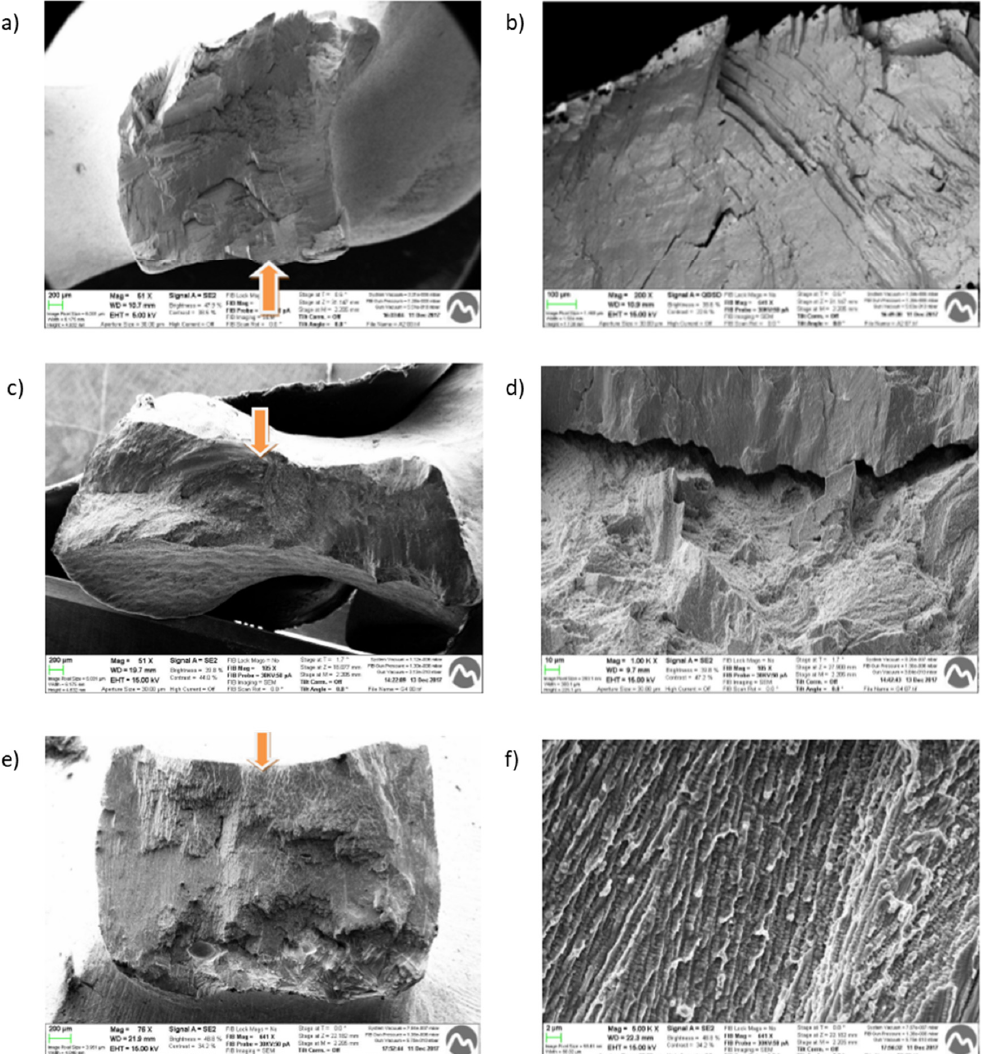
Figure 14. Fractographic images of mechanical tested samples. CADCAM milled samples with brittle fracture ( a,b ). Laser sintered samples with mixed fracture ( c,d ). Casted samples with detail of crack propagation with preferential directionality ( e,f ).